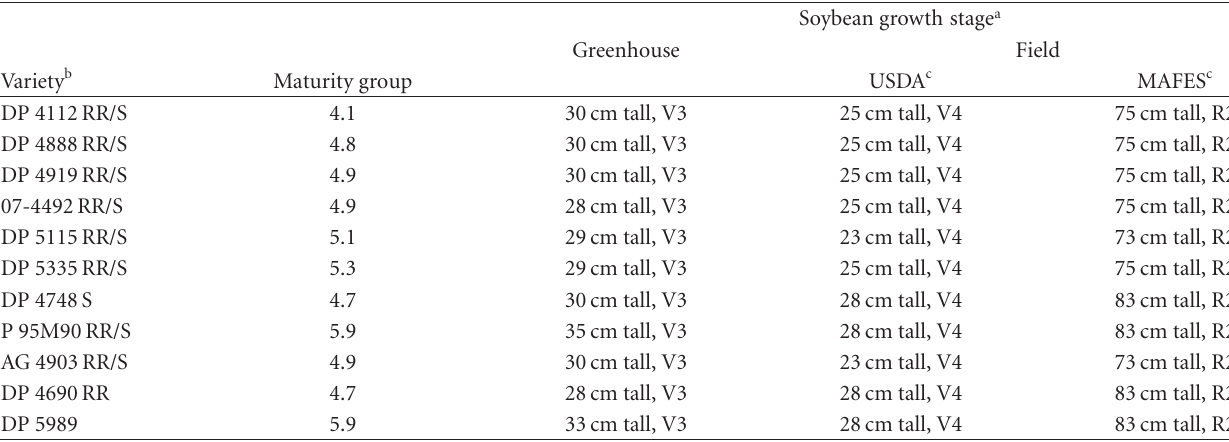
Table 1: Soybean varieties, maturity group, and growth stage at the time of halosulfuron application in greenhouse and field